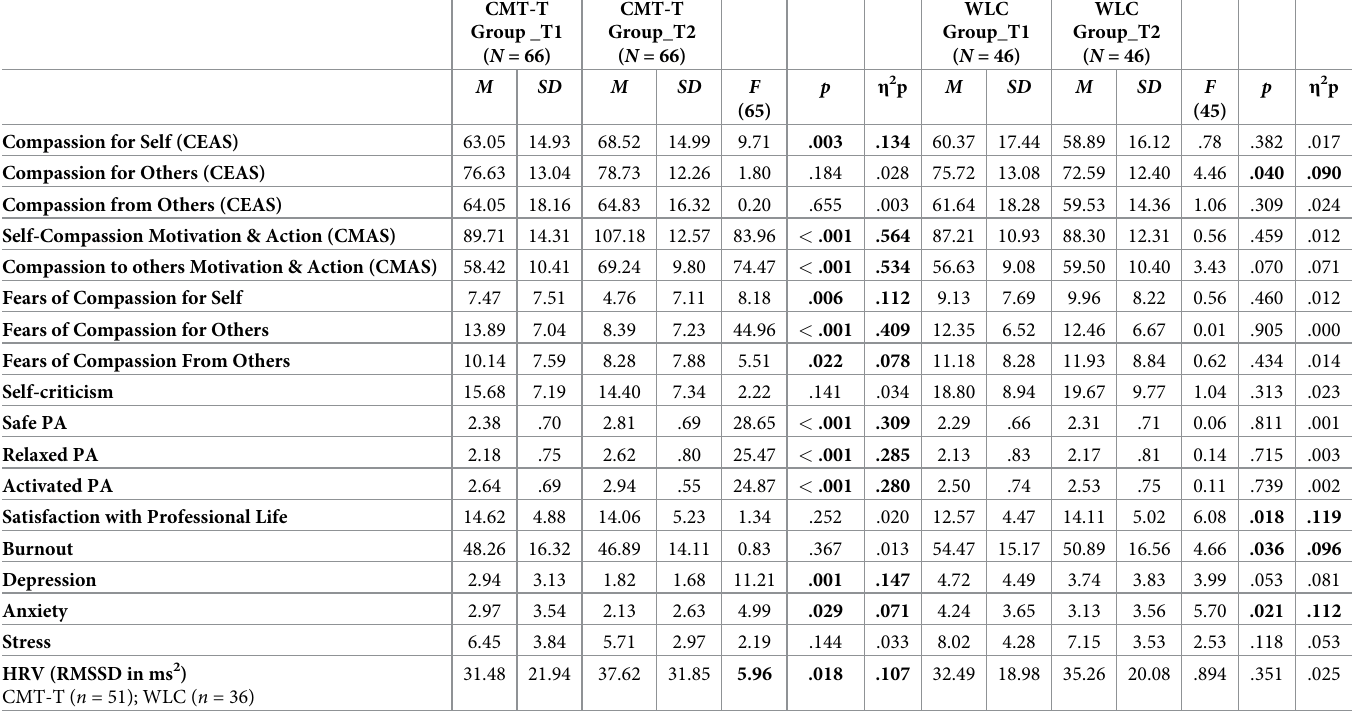
Table 4. Mean comparisons at T1 and T2 in the CMT-T and the in WLC